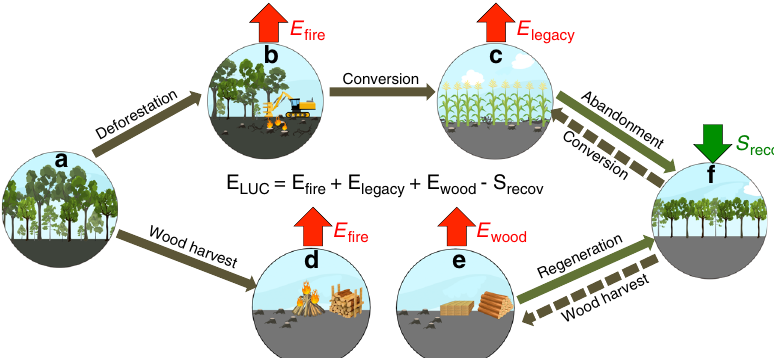
Fig. 1 LUC processes and associated carbon fl uxes. LUC processes considered in this study are: conversion of intact land (exempli fi ed as intact forest ( a )) into agricultural land ( c ), forest wood harvest for fuel wood ( d ), and industrial wood ( e ), and regeneration of secondary forest following harvest or agricultural abandonment ( f ). An old forest was used as an example for intact land in this fi gure, but similar land transitions involving natural grassland were also included. Likewise, pasture was also included as a form of agricultural land. The individual carbon fl uxes comprising E LUC are: b , d E fi re , immediate emissions following forest clearing through burning of aboveground biomass and other on-site disturbance, plus emissions from harvested fuel wood assumed to be burned at the year of harvest; e E legacy , emissions from recently established agricultural land that is dominated by the decomposition of legacy slash and soil carbon inherited from former intact land; b E wood , long-term, gradual carbon release from industrial wood product degradation; and f S recov , carbon sink in recovering secondary forest and grassland. The net land-use change emissions ( S recov , with a positive sign indicating a carbon source to the atmosphere. The dashed arrows indicate conversion of secondary forest (or grassland) into agricultural land in shifting cultivation, or reharvest of wood in case of forest